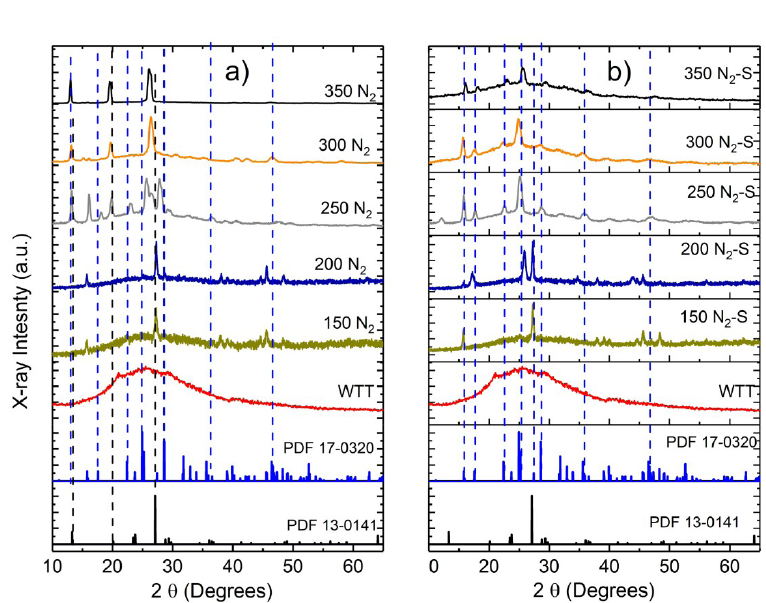
S with a thermal annealed at different temperatures: a) in a nitrogen atmosphere, 2 3